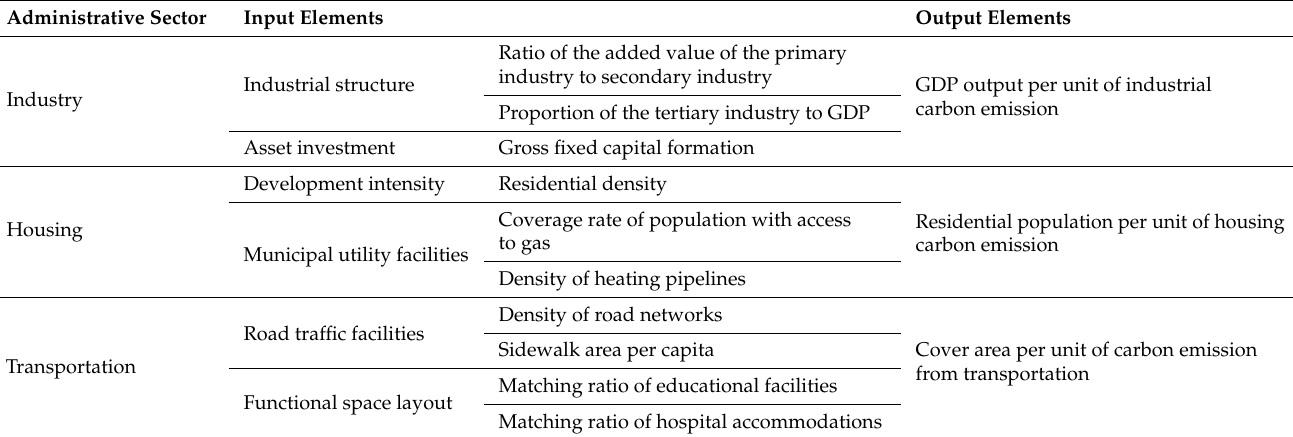
Table 1. The input and output elements of low-carbon management efficiency